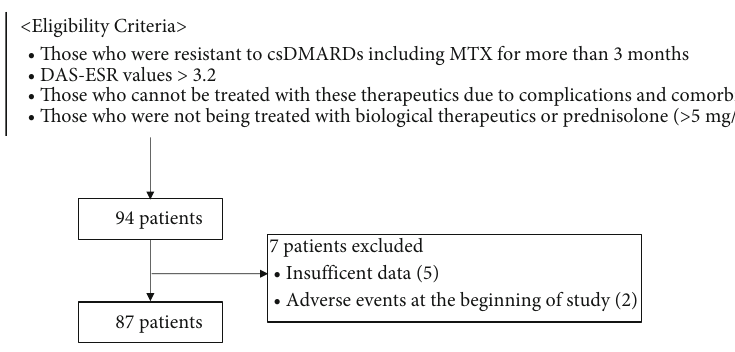
Figure 1: Diagram of the participant selection